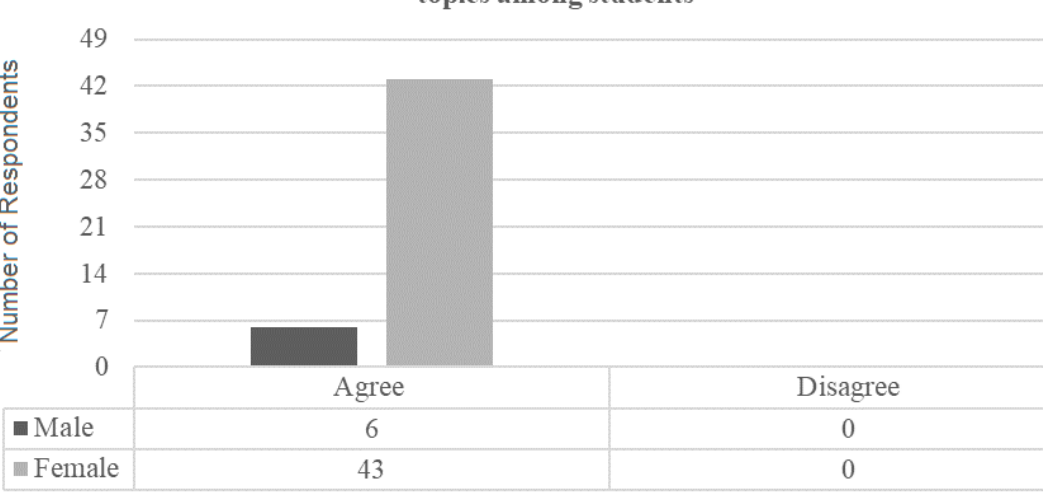
Figure 4. The perception of respondents towards the difficulty of the subject.